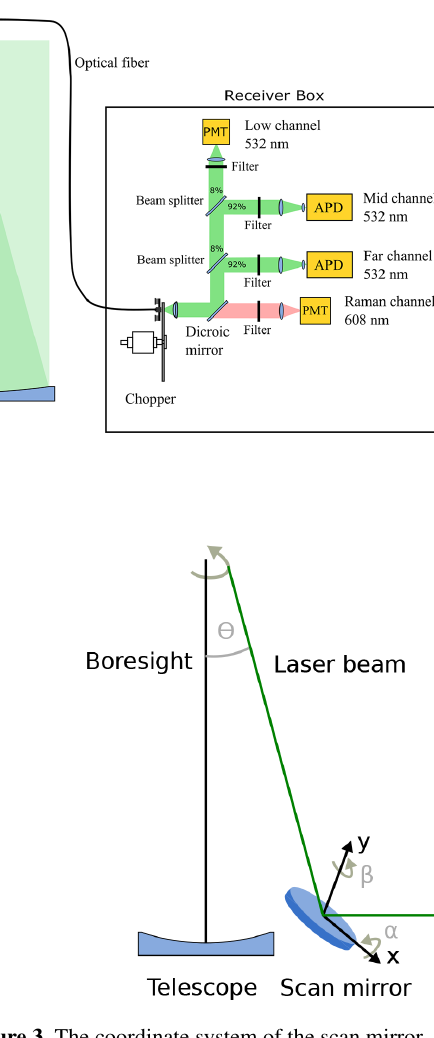
Figure 3. The coordinate system of the scan